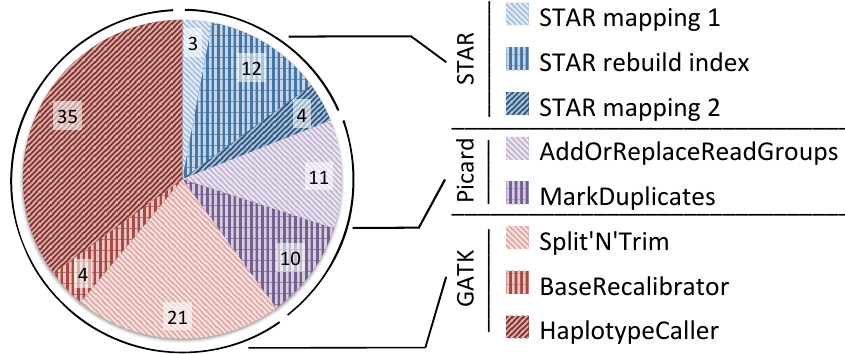
Figure 3. Percentage of time taken by each tool in the GATK RNA-seq pipeline on a single node with 40